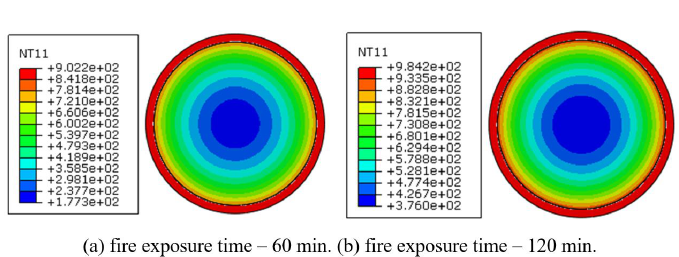
Figure 20. Temperature field obtained from the numerical model with air gap